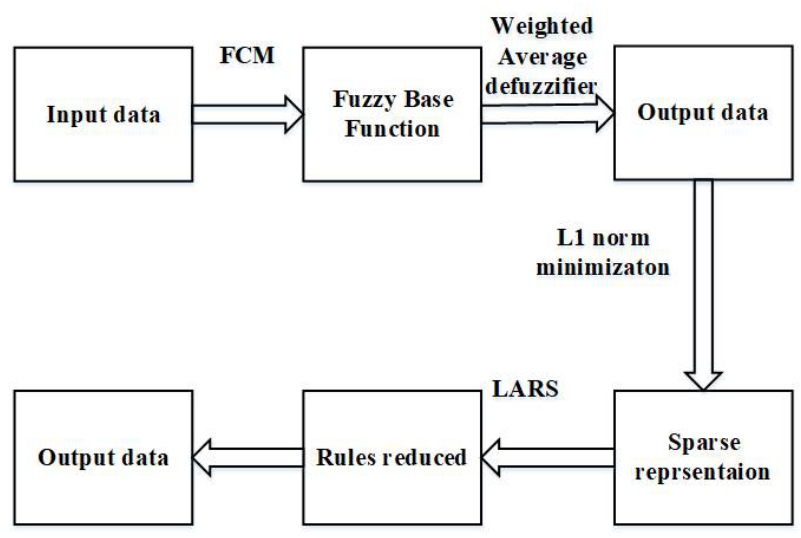
Figure 3. The architecture of the proposed